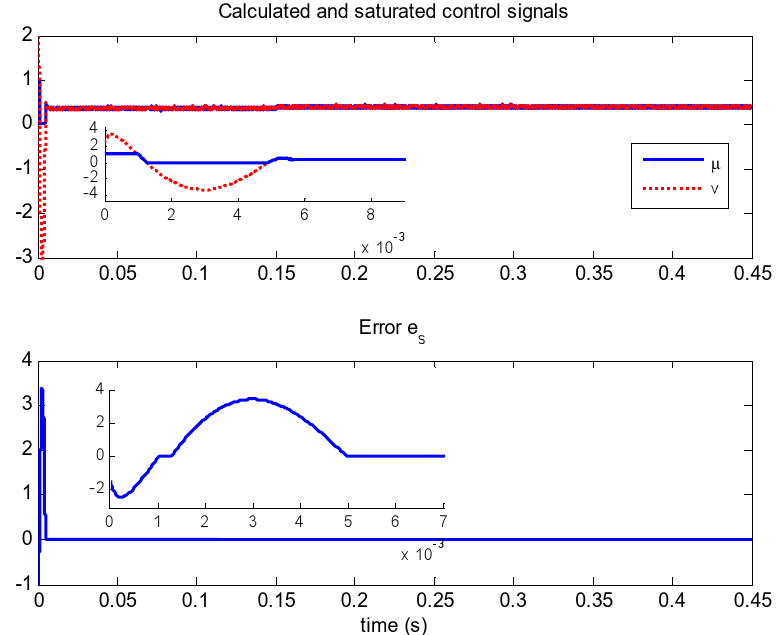
Figure 17. Computed control signal v ( t ) , the applied value µ ( t ) , and the error e s ( t ) in presence of resistance load uncertainty.